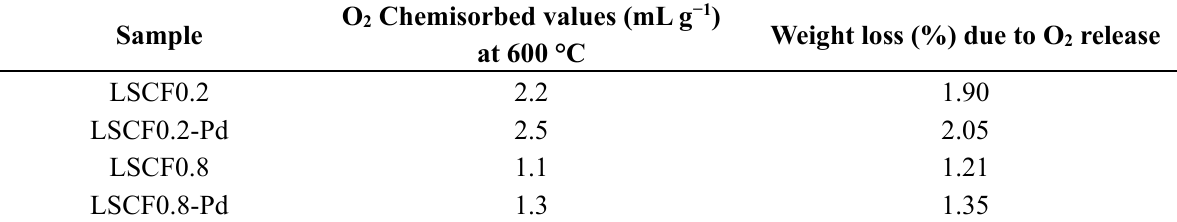
Table 3. Results of oxygen storage capacity (OSC) and thermogravimetric analysis (TGA) analyses on LSCF and LSCF-Pd perovskites